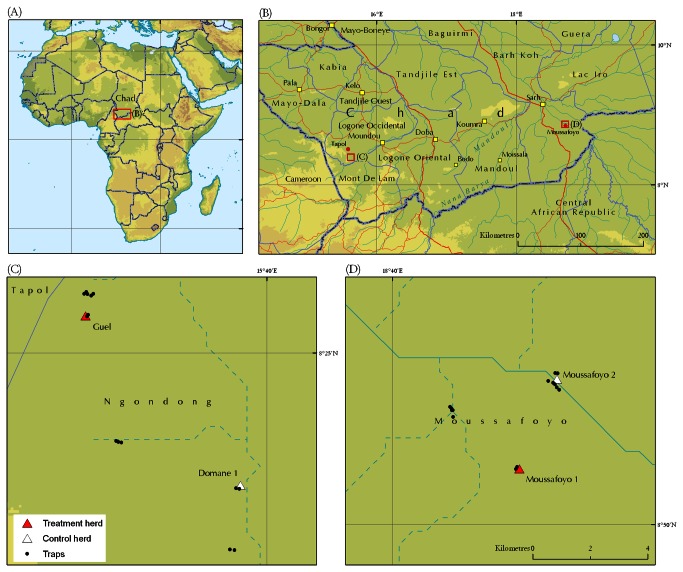
Study sites for impact assessment of footbath insecticide treatment on tsetse apparent density in Chad.The red boxes in panels A and B show the global and specific study areas, respectively, corresponding to panels C and D. The hydrological network shown in sections B, C and D is the HydroSHEDS 15-arcsecond river network of Africa [49].